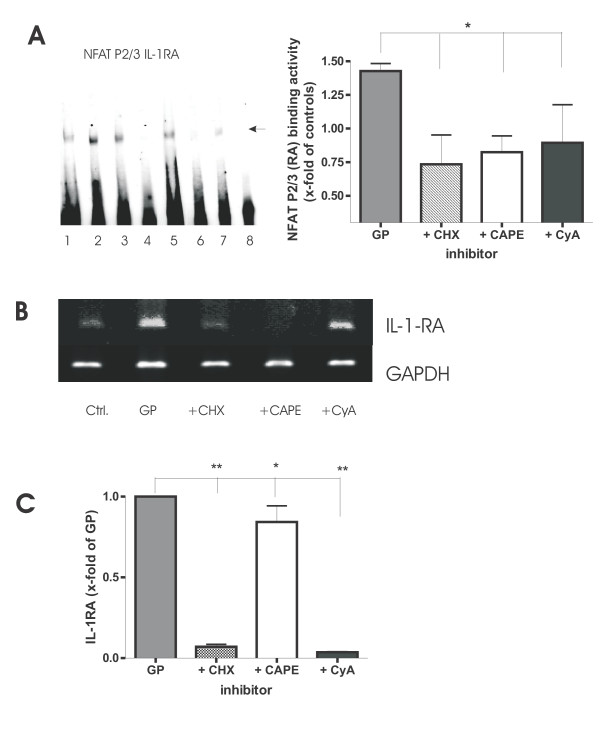
Inhibition of GP-induced NFκB, NFAT and NFIL-6 DNA binding to the IL-1RA promoter. A, A representative autoradiogram (lane 1: control, lane 2: GP, lane 3: GP + unlabeled mutated NFATP2/3 oligo, lane 4: GP + CAPE, lane 5: GP + CyA, lane 6: GP + CHX, lane 7: GP + unlabeled NFATP2/3 oligo, lane 8: water) as well as a graphical summary for the NFATP2/3 site, depicting a decrease in binding following inhibition when compared to GP is displayed (* = p < 0.05). Data are shown as mean ± SEM (n = 4). B, Inhibition of NFκB, NFAT and NFIL-6 resulted in decreased IL-1RA mRNA following CHX, CAPE or CyA compared to GP. GAPDH is used as housekeeping control (representative gel, n = 4). C, Inhibition of NFκB, NFAT and NFIL-6 significantly reduced the production of IL-1RA by human PBMC following treatment with CHX, CAPE or CyA when compared to GP (* = p < 0.05; ** = p < 0.01). Data are shown as mean ± SEM (n = 3).